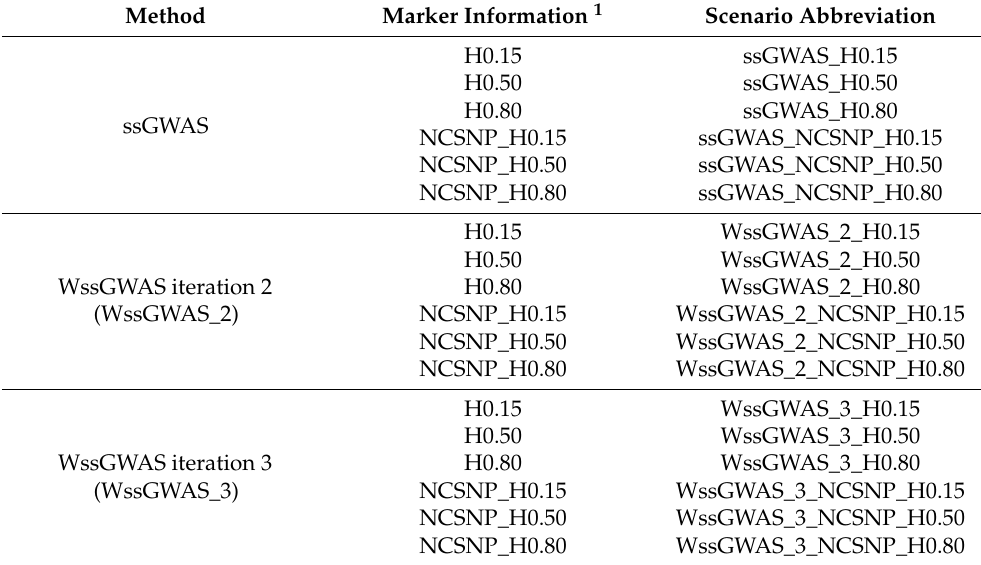
Table 1. Scenarios used to evaluate the traditional and weighted single-step GWAS (ssGWAS and WssGWAS, respectively) using haplotypes for yearling temperament in American Angus